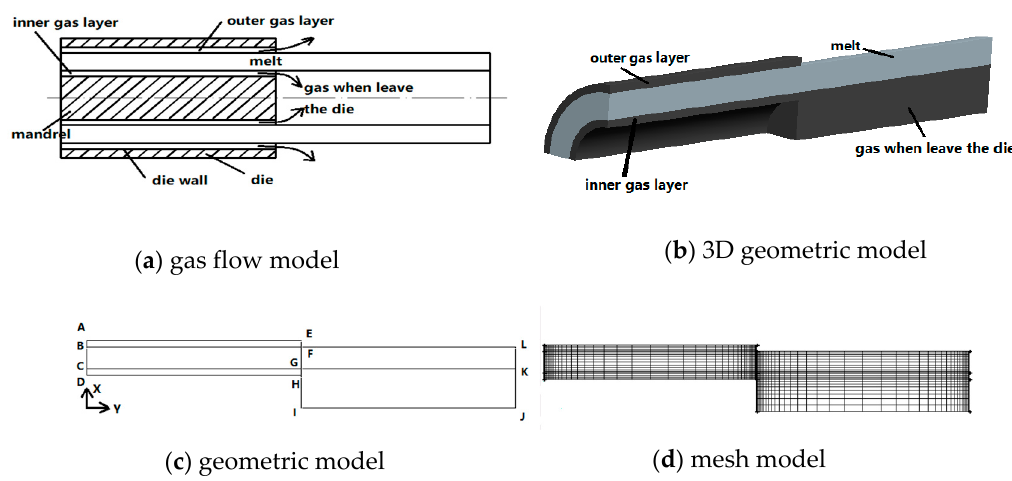
Figure 4. Geometric and mesh models. ( a ) gas flow model, ( b ) 3D geometric model, ( c ) geometric model, ( d ) mesh model.